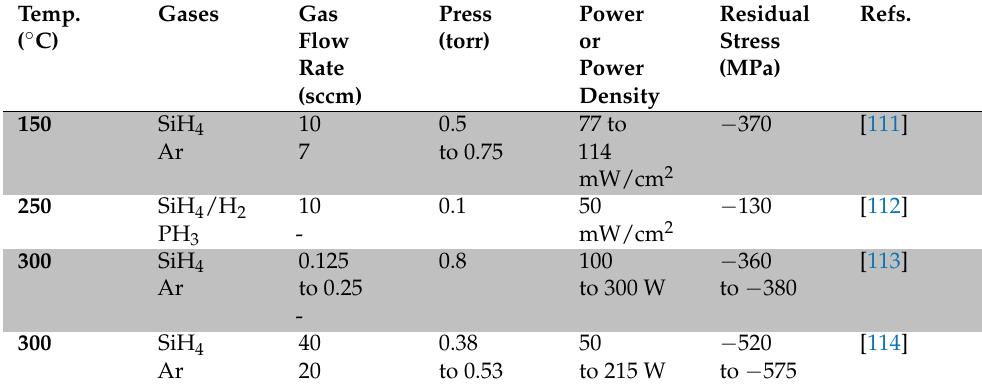
Table 9. Reported Residual Stress of PECVD Silicon as a Function of Processing Conditions.